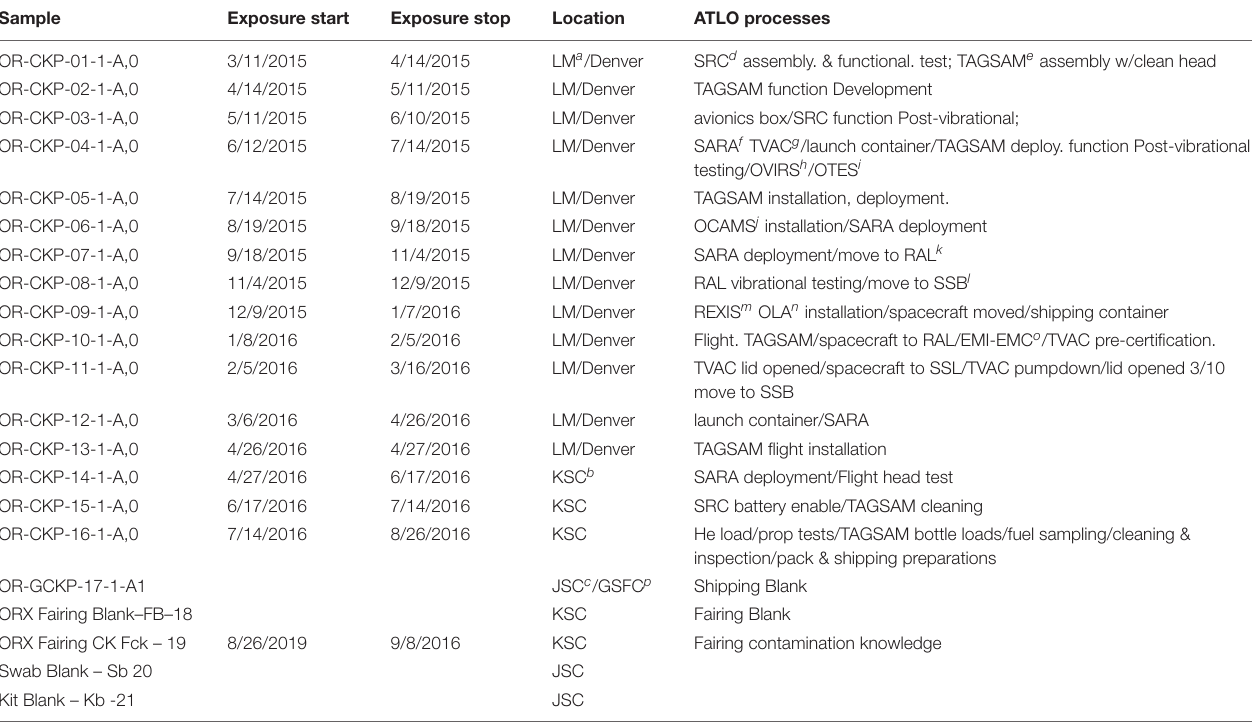
TABLE 1 | Sample information.